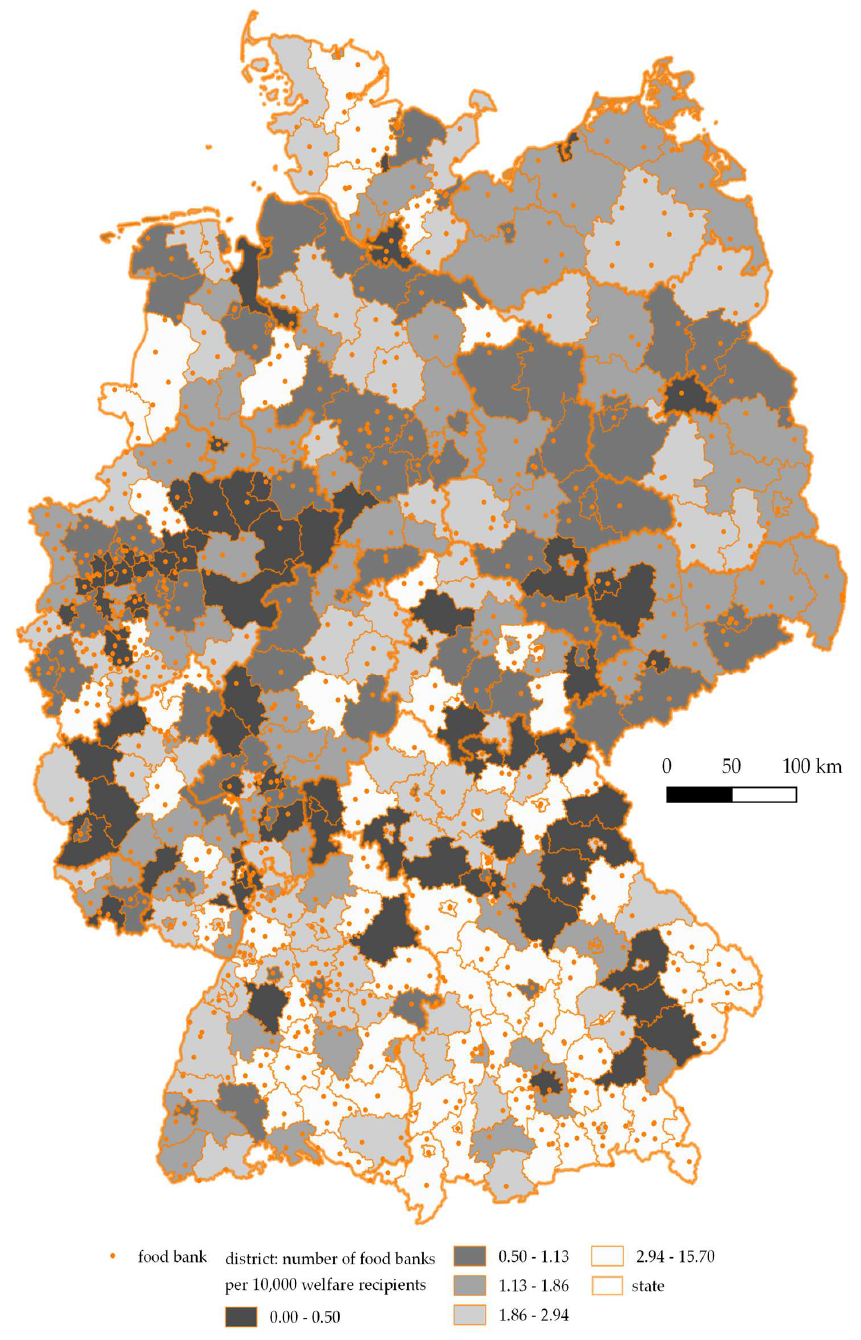
Figure 1. Number of food banks per 10,000 welfare recipients per district in Germany, 2014/2017.